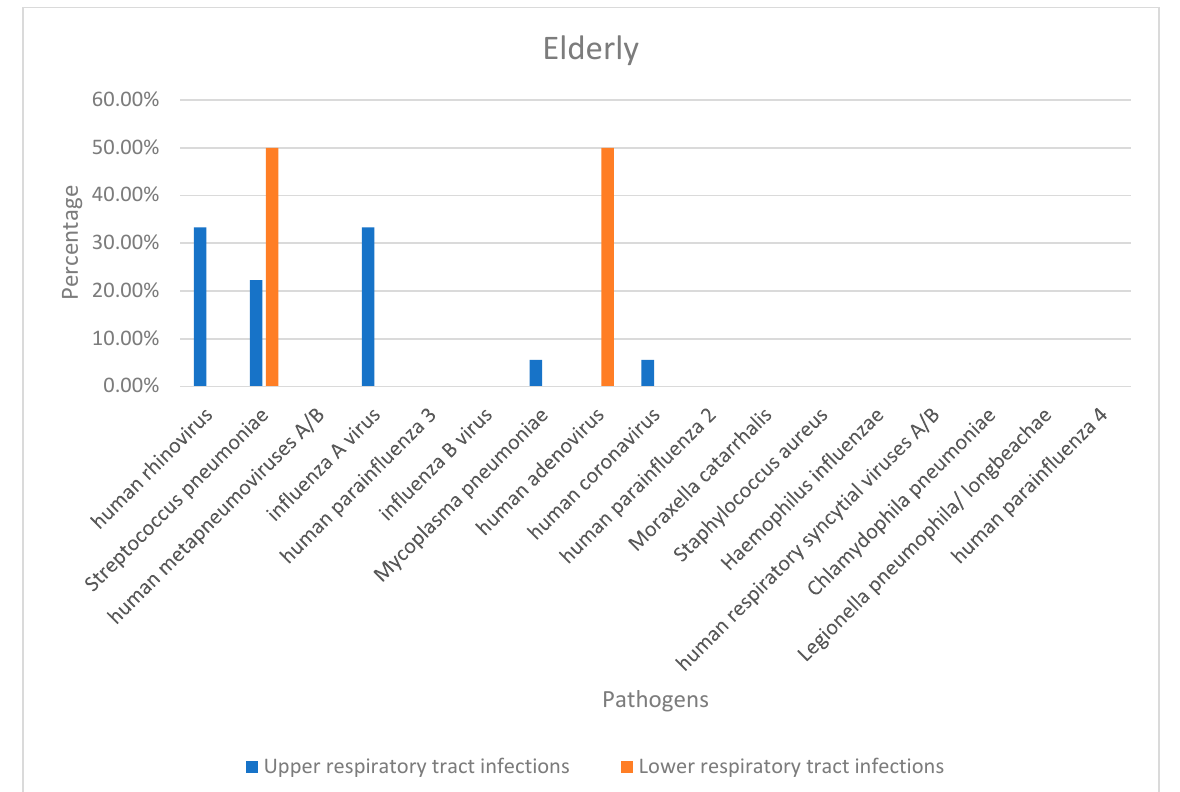
Figure 4. Prevalence of causative pathogens of upper respiratory tract infections and lower respiratory tract infections in paediatric, adult, and older patients.